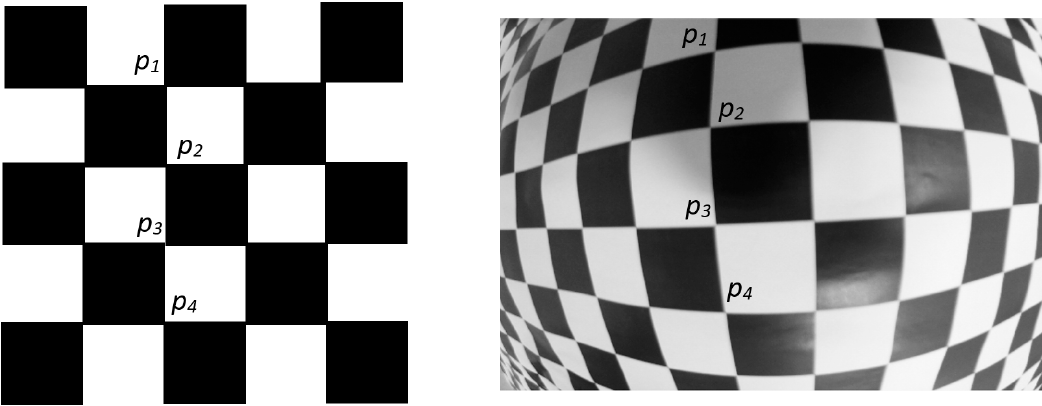
Figure 2. Geometric invariants for correcting points locations detected in the image. Template features remain under perspective projection also in distorted images. Cross ratio guaranties that parallel lines remain parallels under perspective projection. Straight lines are also straight under perspective projection.